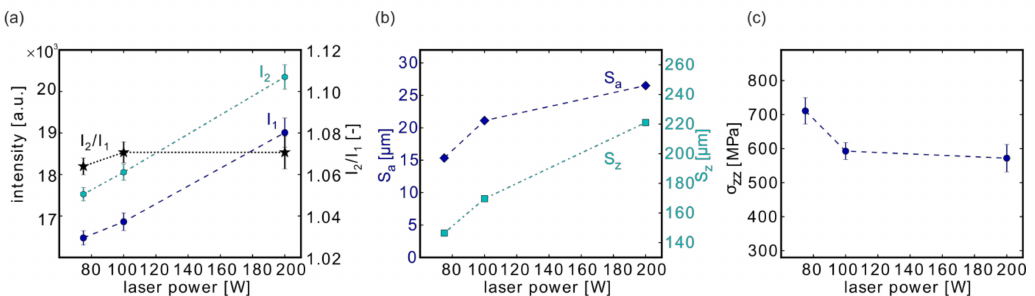
Figure 8. Influence of the power on the MPM data ( a ), on the surface roughness ( b ), and on the residual stresses ( c ). Depicted are the results from samples #11 (P CL = 75 W), #05 (P CL = 100 W), #12 (P CL = 200 W). Note: The lines connecting the measurement points are only provided as a guide for the